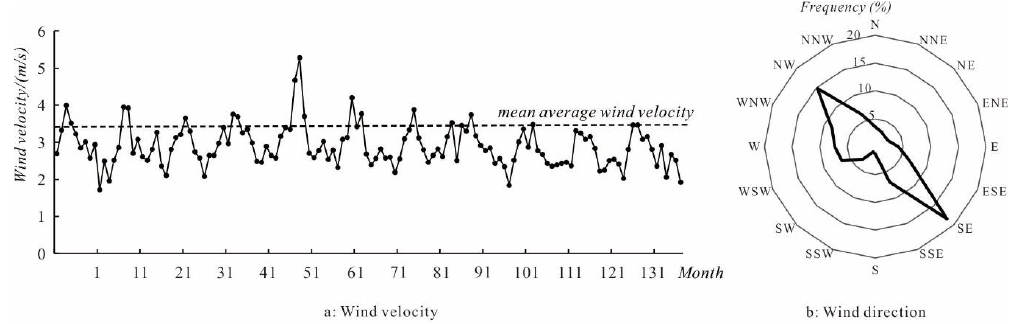
Figure 2. The annual average wind speed ( a ) and wind direction ( b ) of Haiyan Weather Station in the past 10 years (2006 to 2016).